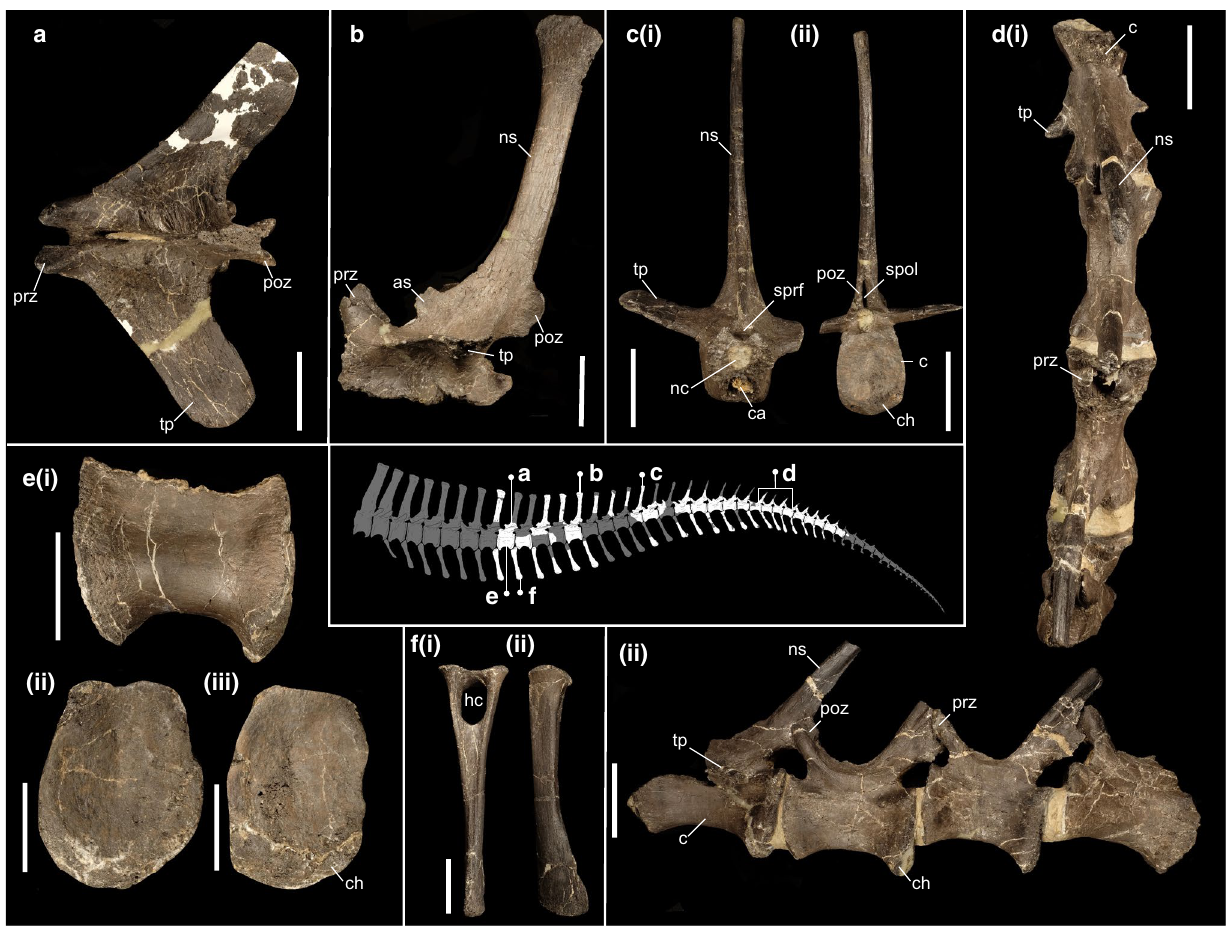
Figure 5. Caudal material referred to Riparovenator milnerae . ( a ) Anterior neural arch (IWCMS 2020.447.3) in dorsal view; ( b ) anterior neural arch (IWCMS 2020.447.2) in left lateral view; ( c ) partial middle vertebra (IWCMS 2020.447.8) in (i) anterior and (ii) posterior views; ( d ) articulated mid-caudal series (IWCMS 2020.447.12) in (i) dorsal and (ii) left lateral views; ( e ) anterior centrum (IWCMS 2020.447.5) in (i) left lateral, (ii) anterior and (iii) posterior views; ( f ) anterior chevron (IWCMS 2020.447.20) in (i) anterior and (ii) left lateral views. as anterior spur, c centrum, ca cavity, ch chevron contact, h haemal canal, nc neural canal, ns neural spine, poz postzygapophysis, prz prezygapophysis, spof spinopostygapophyseal fossa, sprf spinoprezygapophyseal fossa, tp transverse process. Tail reconstruction credit: Dan Folkes (CC-BY 4.0). Scale bars: 50